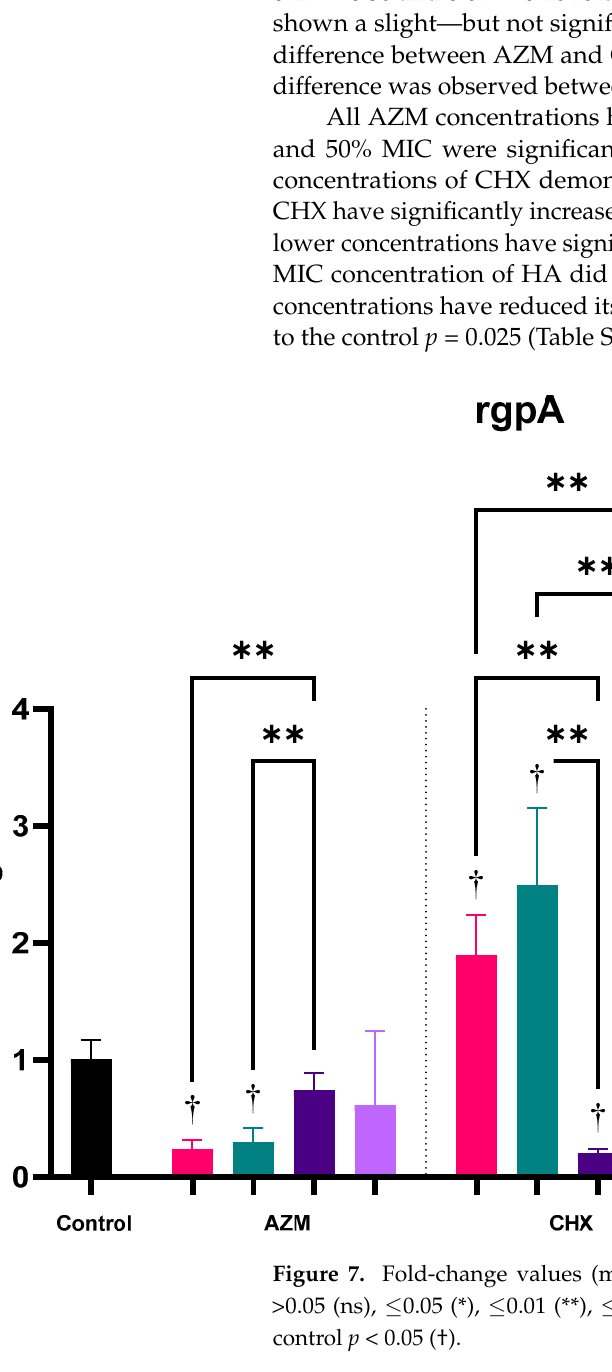
Figure 6. Fold-change values (mean ± SD) of different concentrations on expression of hagA. >0.05 (ns), ≤ 0.05 (*), ≤ 0.01 (**), ≤ 0.001 (***), ≤ 0.0001 (****). Statistically significant compared to control p < 0.05 (†).